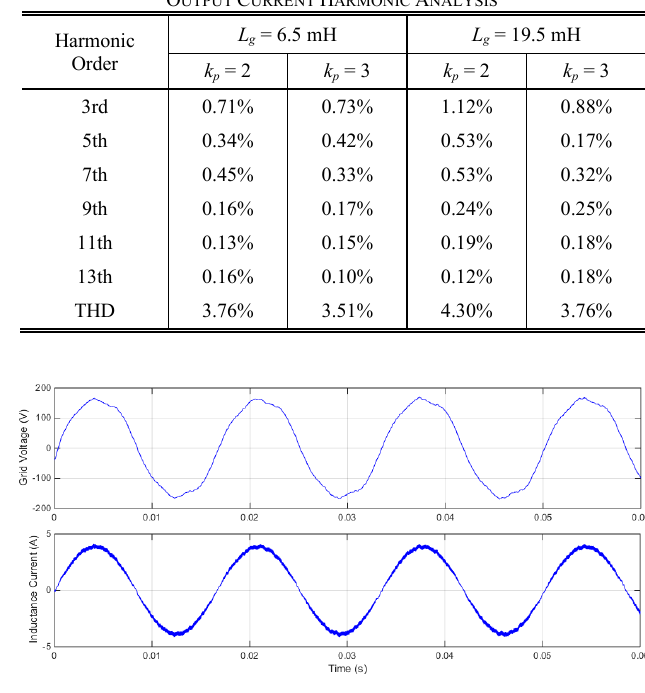
Fig. 11. Output voltage and output current when L g = 19.5 mH ( τ i = 0.0005)